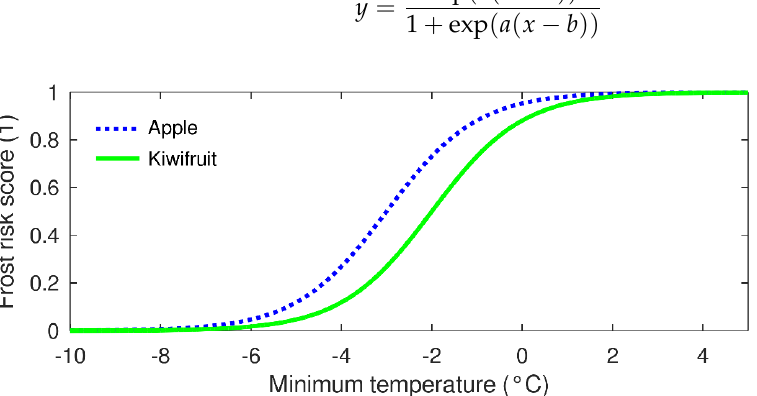
Figure 2. Frost risk score for daily minimum temperatures for apple and kiwifruit. A higher score indicates less frost risk.